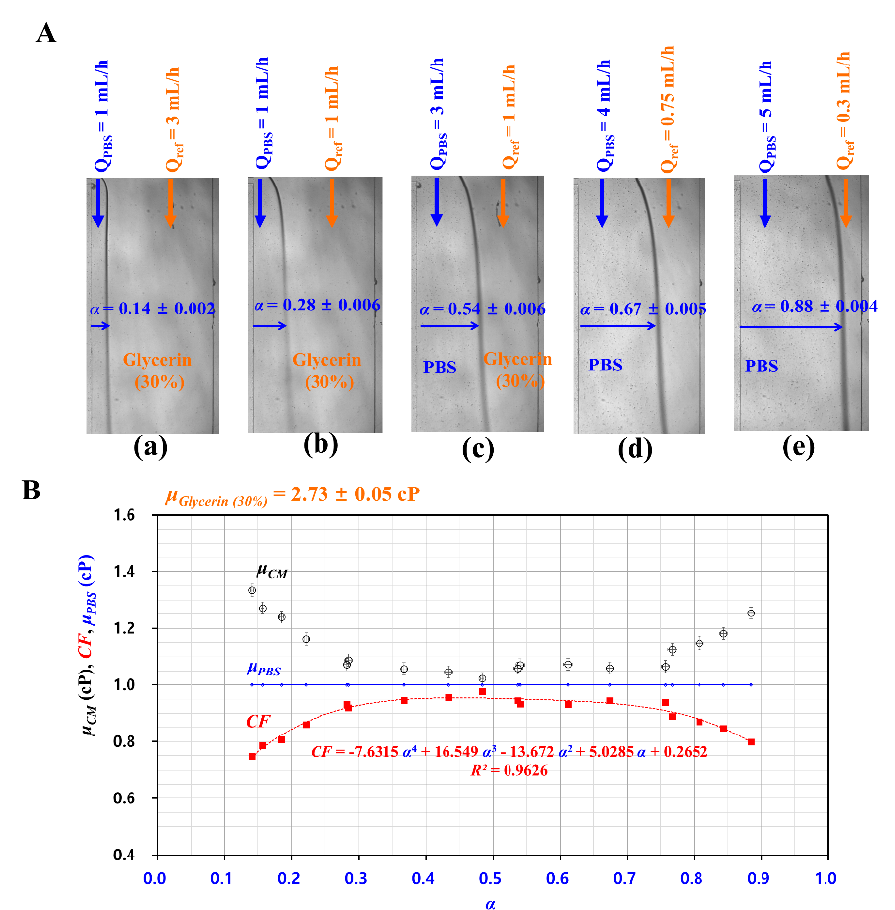
Figure A1. Correction factor of parallel flow method estimated by conducting experimental results.